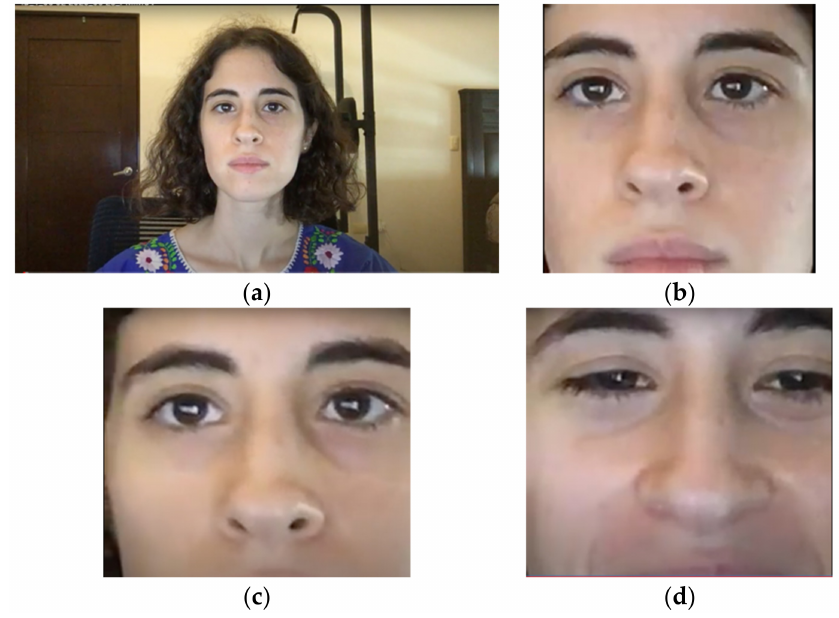
Figure 2. ( a ) Frame from original video taken from camera; ( b ) cropped frame according to ROI; ( c ) image cropped left side of face; ( d ) blurred frame caused by sudden